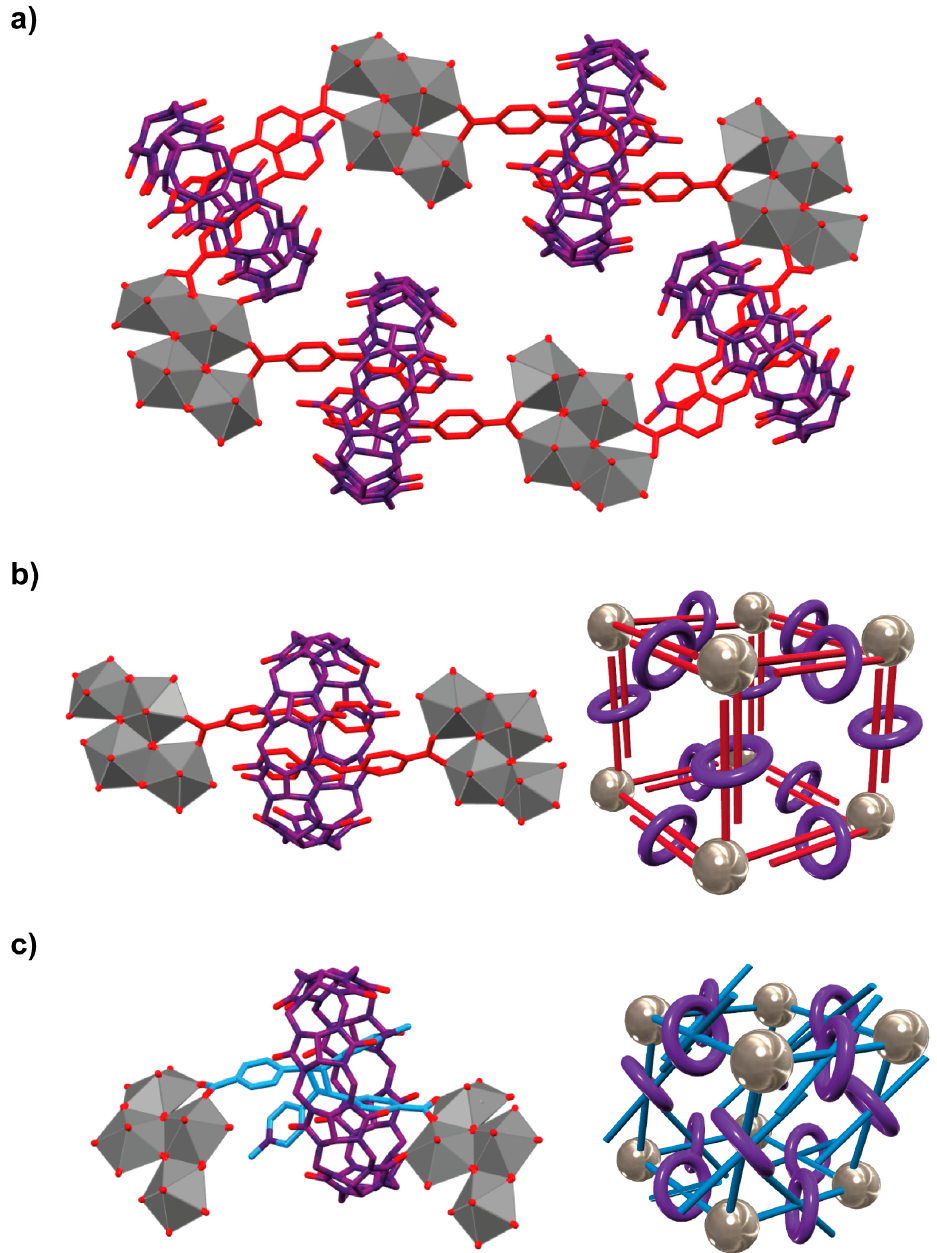
Figure 18. ( a ) Stick representation of the crystal structure of U-CB[8]-MPyVB showing a square grid of pseudorotaxanes connected to different uranium clusters; ( b ) stick representation of a single pseudorotaxane connected to two different uranium nodes ( left ) and cartoon representation of U-CB[8]-MPyVB ( right ); ( c ) stick representation of the crystal structure of the interlocked photodimerization product within the MOF matrix ( left ) and cartoon representation of the deformation in the crystalline array as a consequence of the photoirradiation ( right ) involving quinone loading, photorelease and thermal treatment [53]. Color key: grey = uranium atoms; purple = carbon atoms of the cucurbituril macrocycle and nitrogen atoms; red = carbon atoms of the styrylpyridinium-based compounds and oxygen atoms; blue = carbon atoms of the cyclobutane-based compounds; purple toroid = cucurbit [8]uril macrocycle; red rods = styrylpyridinium-based compounds; crossed blue rods = cyclobutane-based compounds.